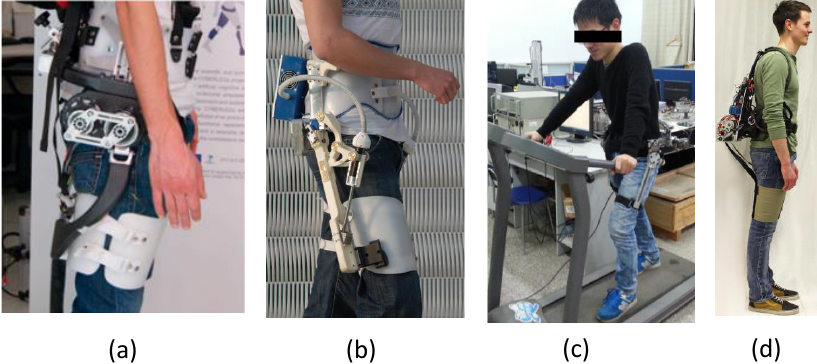
Figure 4. ( a ) exoskeleton developed by Giovacchini et al. [16]; ( b ) HiBSO (hip ball screw orthosis) [17]; ( c ) PH-EXOS [18]; ( d ) Exosuit